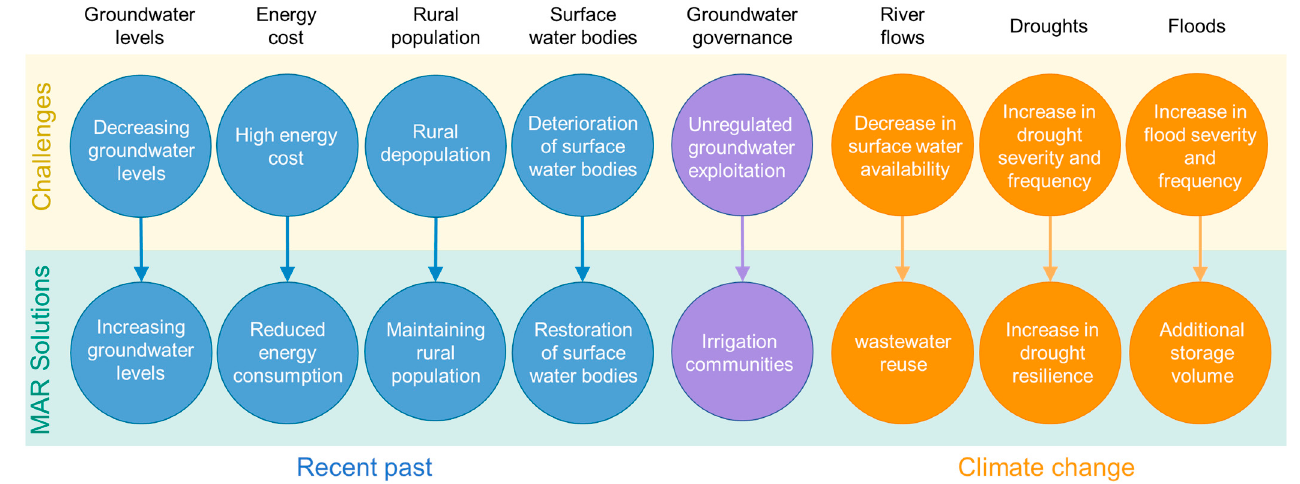
Figure 3. Socio-economic challenges related to water resources identified in the study area and their corresponding managed aquifer recharge (MAR) solutions. The top row presents thematic categories in the Approach and Results and Discussion sections. The recent past challenges and MAR solutions are on the left-hand side, in blue. Climate change challenges and their corresponding MAR adaptive solutions are on the right-hand side, in orange. A challenge-MAR solution pair from the recent past with implications for climate change adaptation is presented in the centre, in purple.